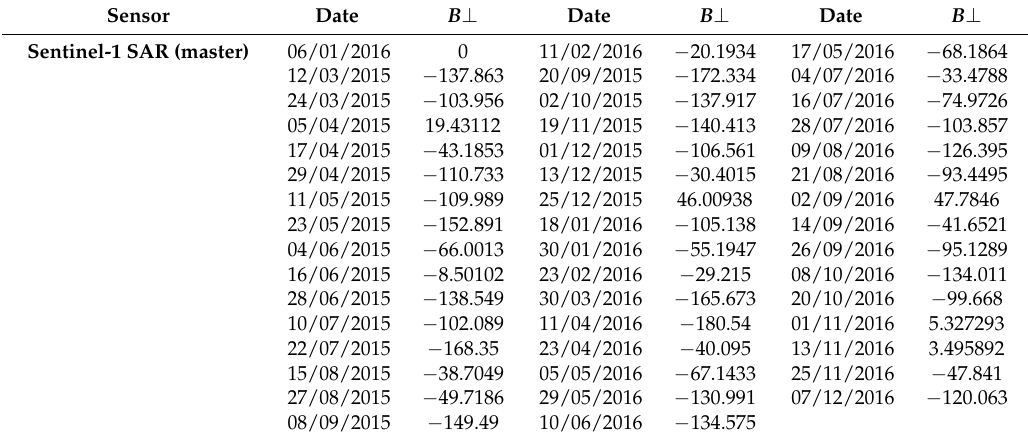
Table A2. Sentinel-1A images dates and perpendicular baseline B ⊥ relative to the master image